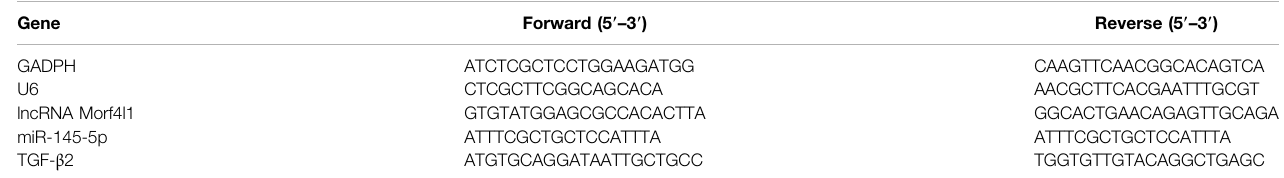
TABLE 1 | Primer sequence.